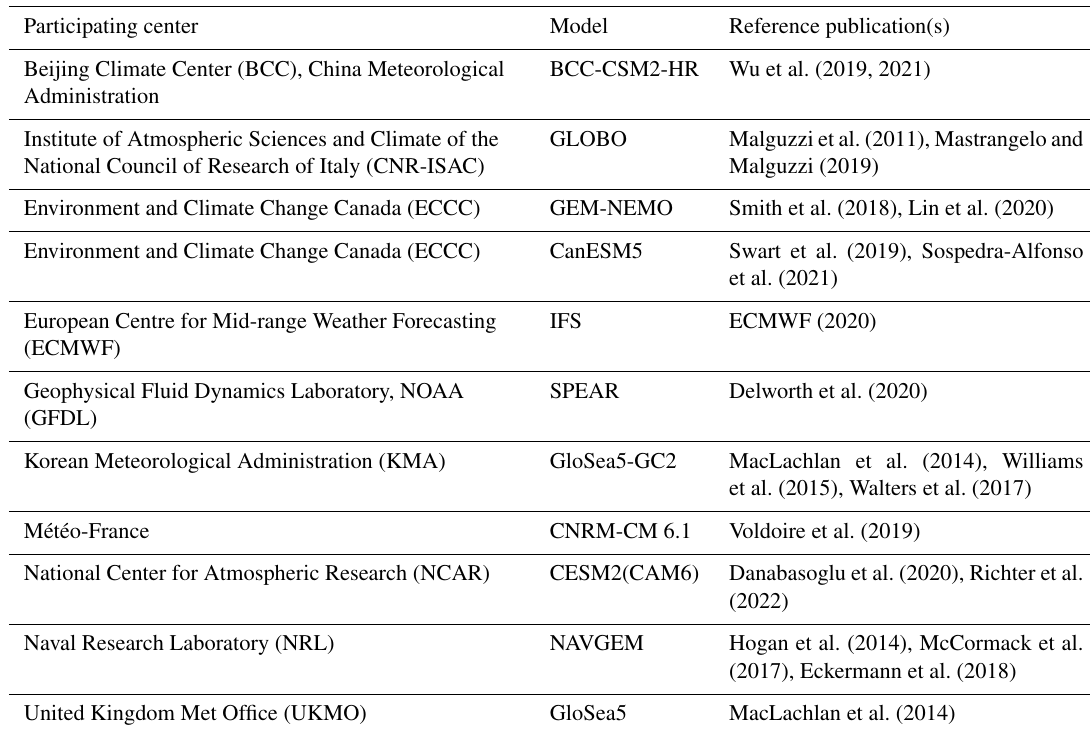
Table 6. Participating centers, models, and reference